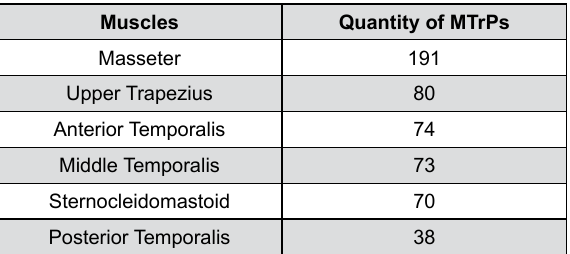
Figure 1- Distribution of MTrPs on the muscles evaluated, in decreasing order of prevalence